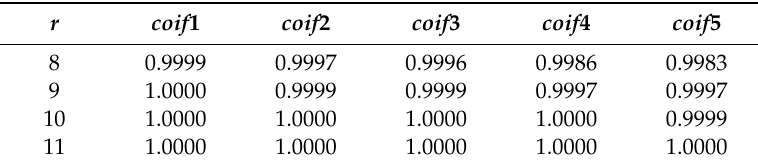
Table 30. Experimental results ( SSIM ) of 3D tomographic 16-bit image “Body_1.0” DWT by using bit-width r of coiflets filters coe ffi cients. r